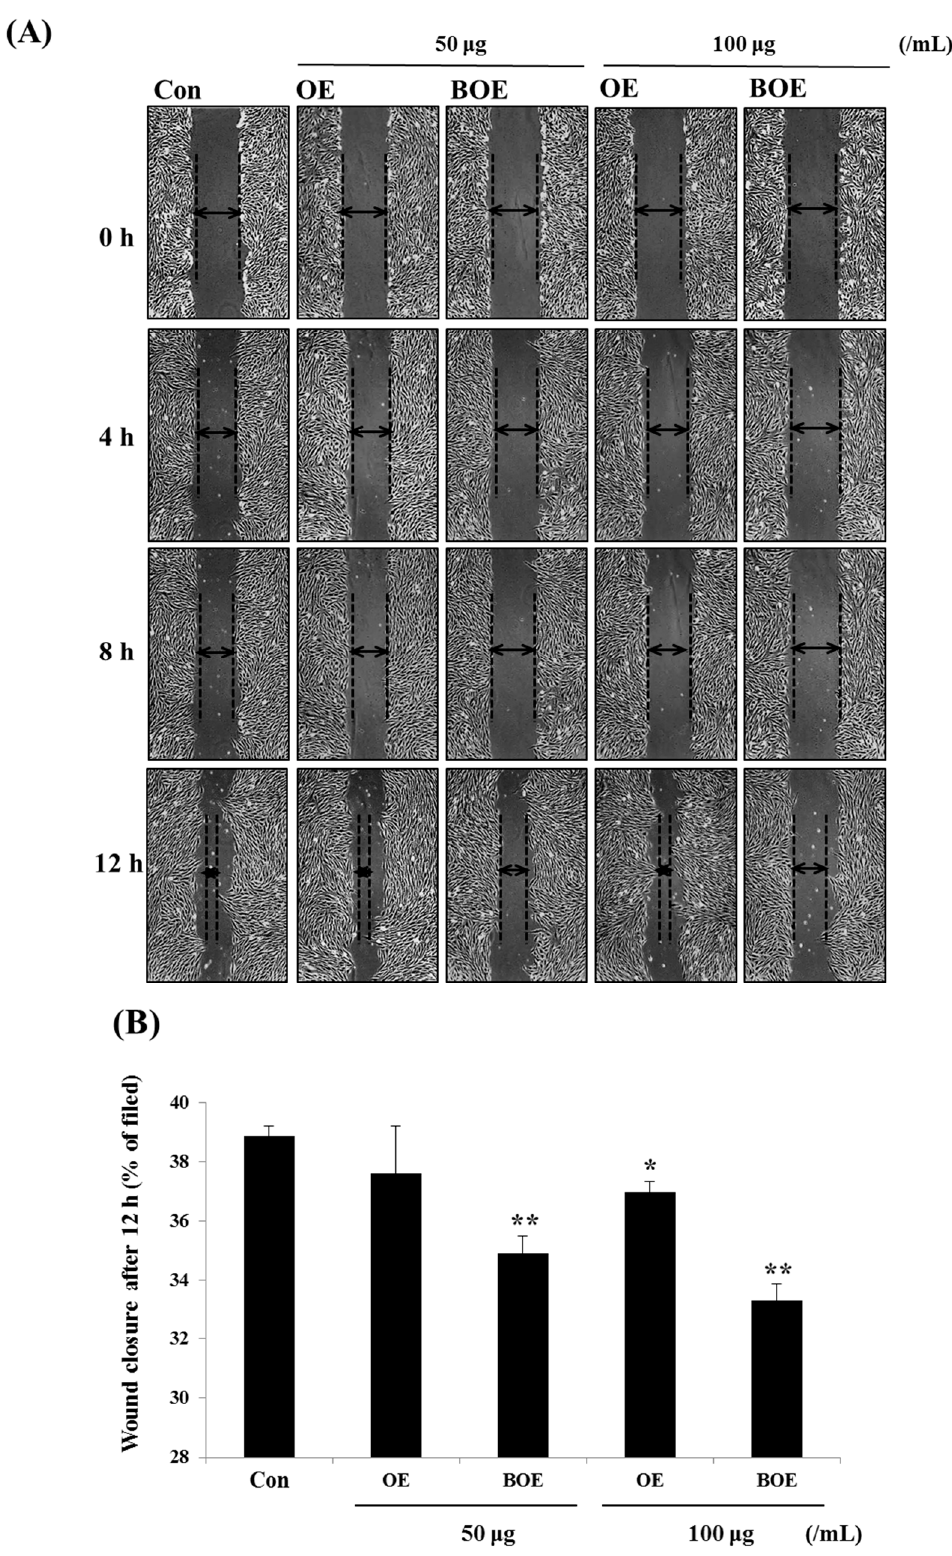
Figure 2. Figure 2. Cont.